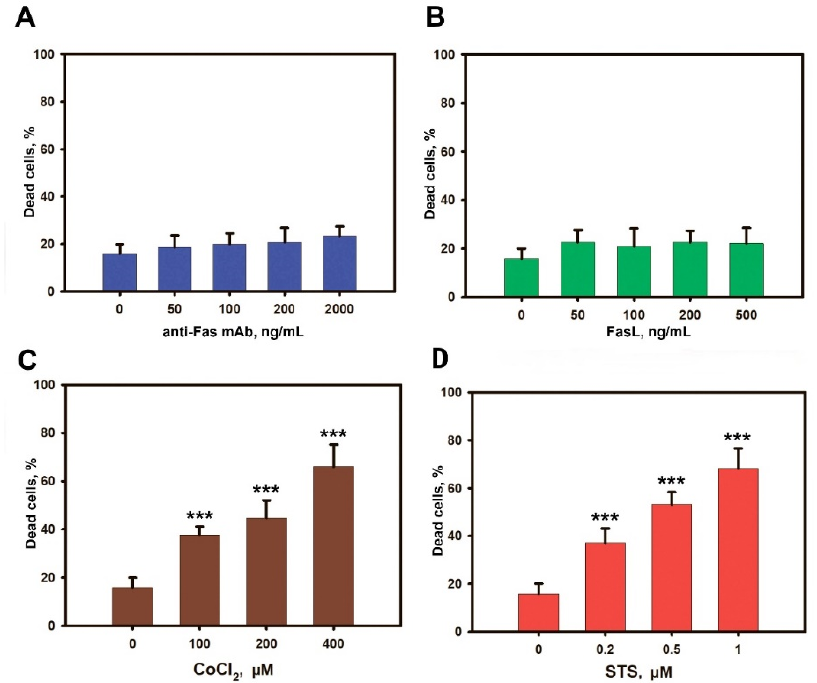
Figure 2. Flow cytometry analysis of L ‐ MSC cell death. L ‐ MSCs were incubated with anti ‐ Fas mAb ( A ); FasL ( B ); CoCl 2 ( C ), or STS ( D ) for 72 h. Data are presented as the percentages of the cells with the fragmented DNA. The results from three L ‐ MSC cultures isolated from individual patients are shown. *** p < 0.001.